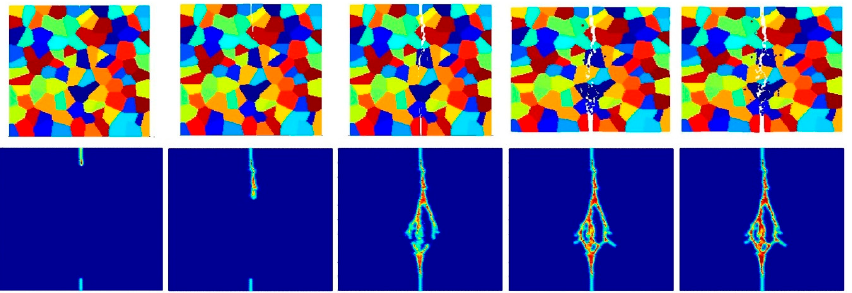
Figure 21. Fracture pattern of polycrystal when β = 2.0 with 150 × 150 particles. From left to right: time = 1.5 μ s, 2.0 μ s, 2.5 μ s, 3.0 μ s, and 3.5 μ s, respectively.